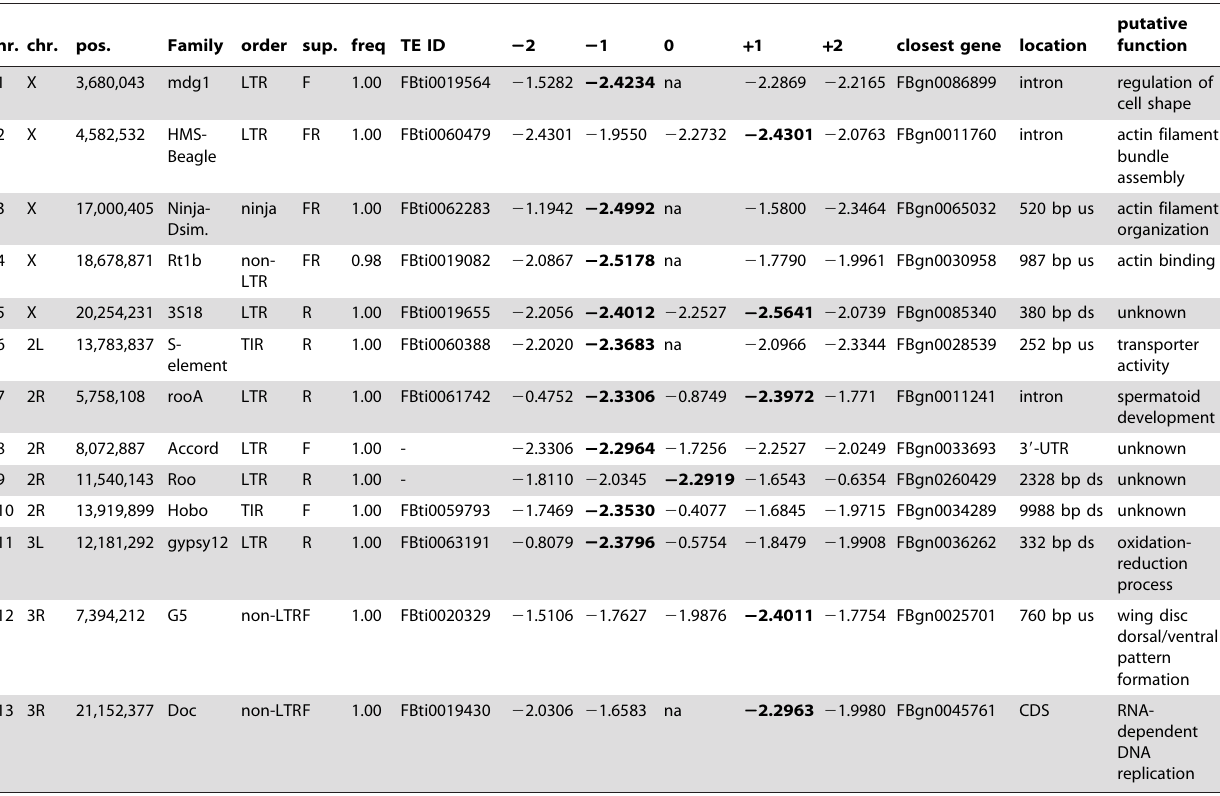
Table 5. Candidate positively selected TE insertions.